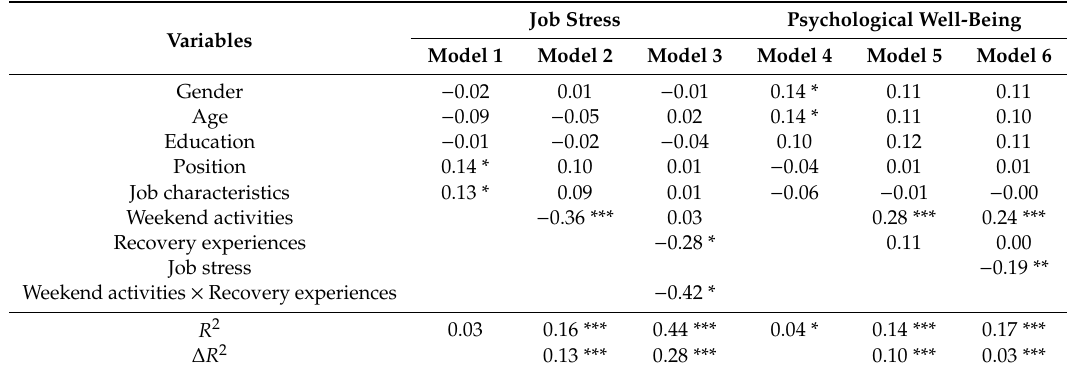
Table 3. Hierarchical multiple regression for job stress and psychological